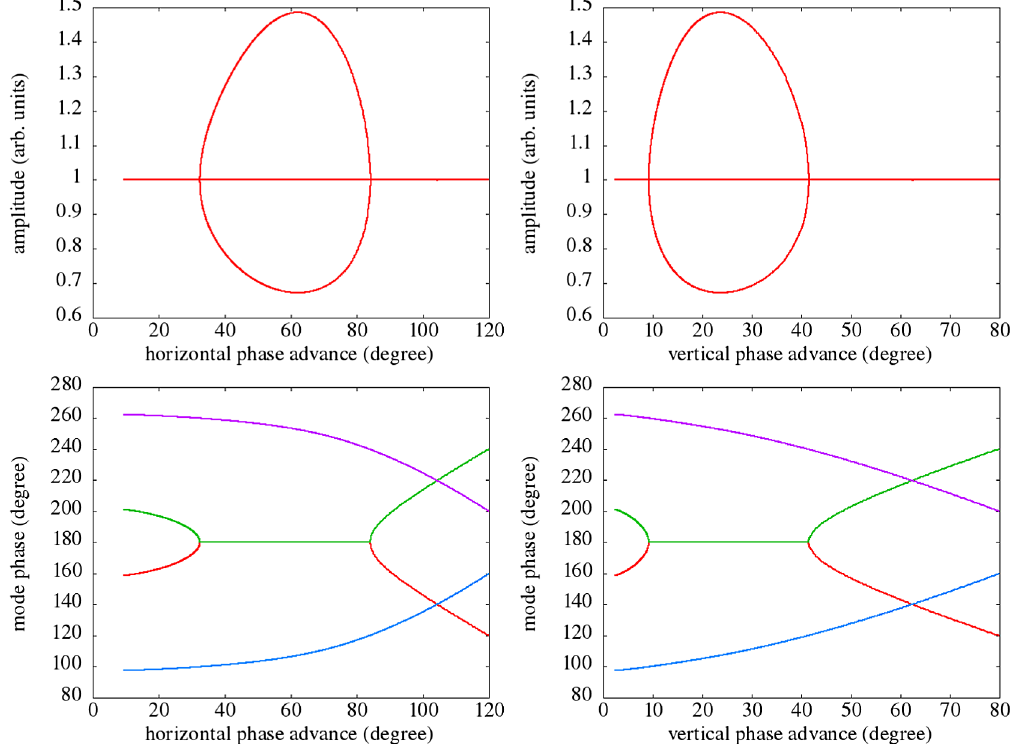
FIG. 14. The 2D envelope mode (top) growth rate amplitudes and (bottom) phases as a function of depressed phase advance with asymmetric zero current phase advances ( 80 ° in one direction and 120 ° in another direction) in a periodic quadrupole channel. The four colors in the bottom plots are the phases of the four